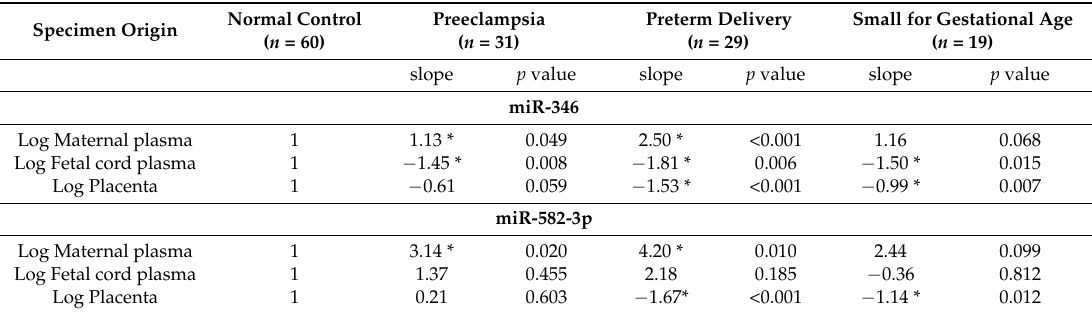
Table 3. Slope of log miR-346 and log miR-582-3p expression in three specimens of included study